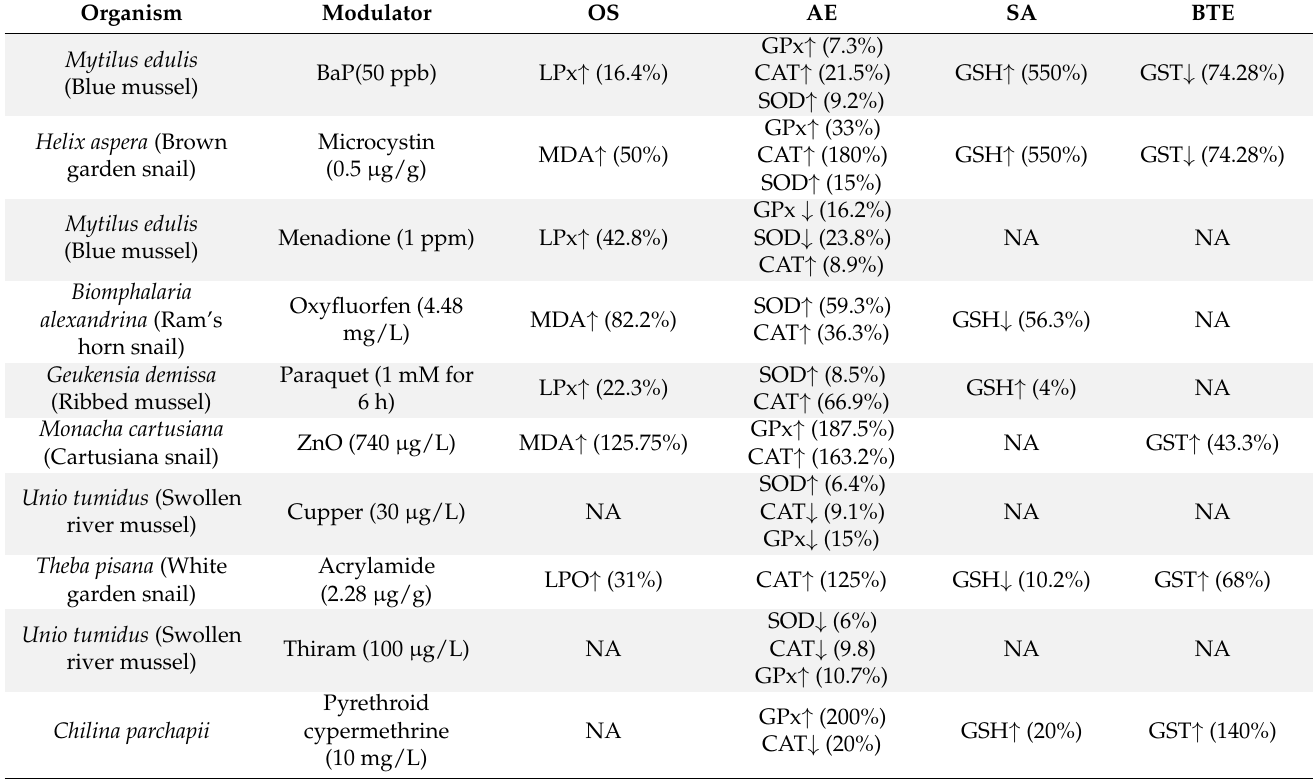
Table 1. Oxidative physiology status of different molluscs in response to different